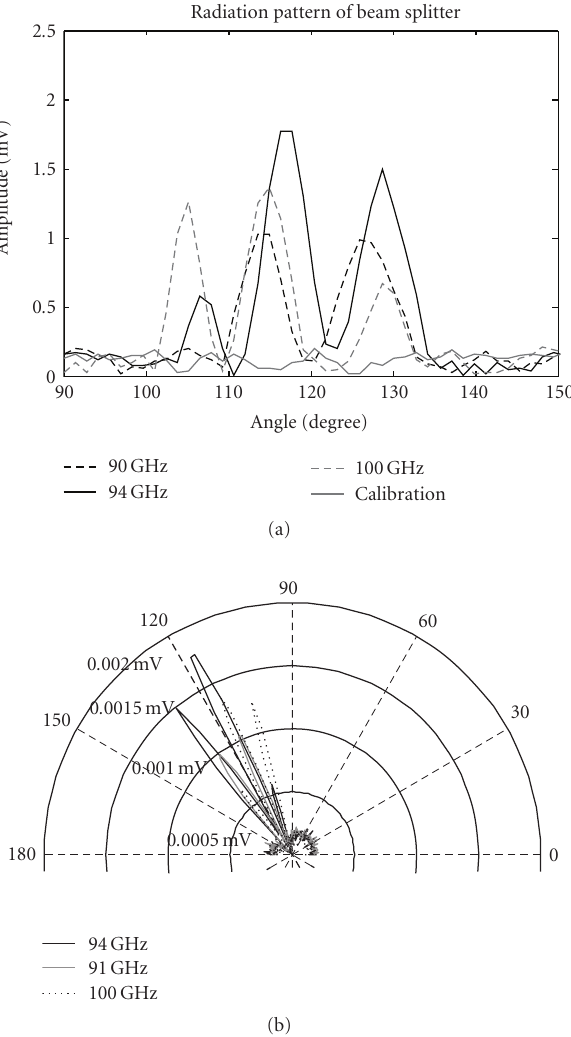
Figure 5: Measured near field radiation pattern of beam splitter array at di ff erent incident frequencies: (a) rectangular plot (b) polar